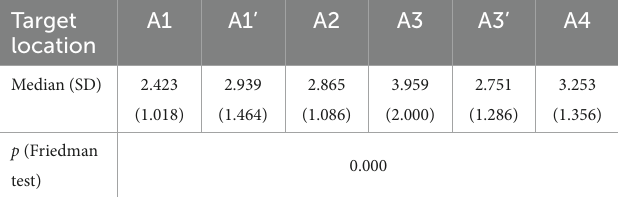
TABLE 6 Results of the searching time along the different